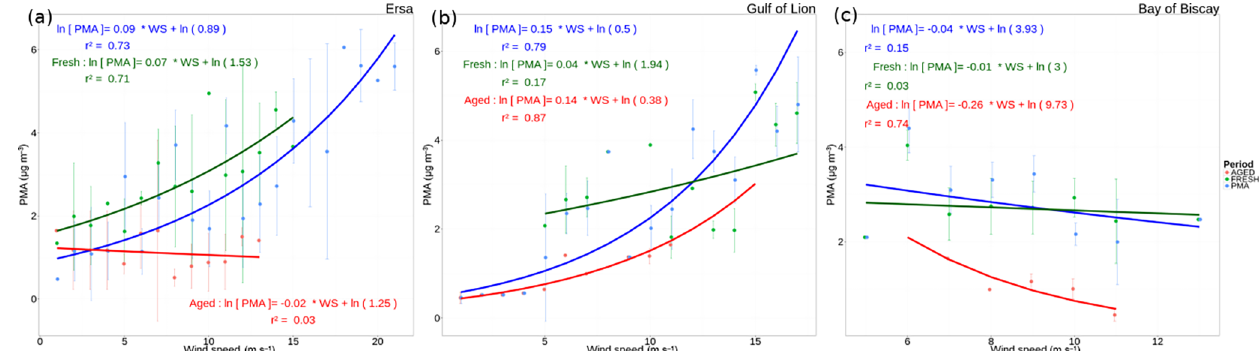
Figure 11. Concentration of sea salt aerosols measured by the PILS IC as a function of wind speed measured at Ersa (a) , at the Gulf of Lion buoy (b) and at the Bay of Biscay buoy (c) , for the PMA period. Offsets of 12h and 60h have been applied between the wind speed measurements in the Gulf of Lion and the Bay of Biscay respectively and the PMA concentrations observed at Ersa to account for transport time of the air masses. The PMA concentrations have been averaged by wind speed bins of 1ms − 1 . The error bars represent ± 2 σ/ curves represents all the PMA measurements, while green and red curves represent fresh and aged